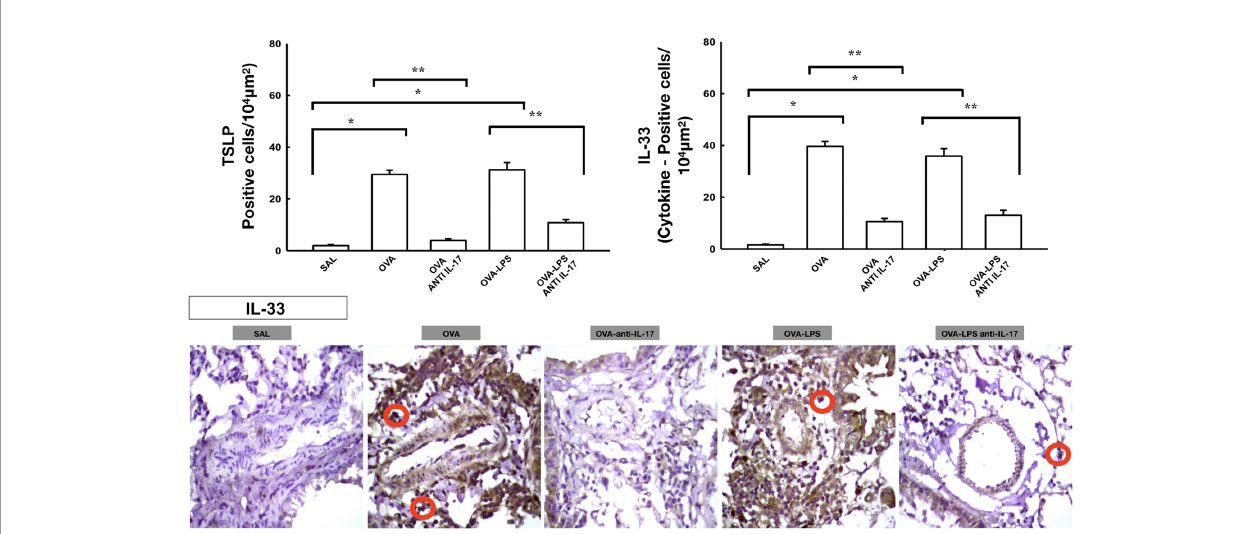
FIGURE 8 | Effects of anti-IL 17 treatment on TSLP and vascular IL-33. The values represent the mean ± SE of TSLP and IL-33 for all experimental groups. The differences were considered signi fi cant when p<0.05. *p<0.05 vs. SAL group; **p<0.05 vs. OVA and OVA – LPS groups. Photomicrograph pulmonary vessels measuring IL-33. The animals exposed to only ovalbumin and ovalbumin plus LPS (OVA and OVA – LPS groups) presented prominent increases in the numbers of positive cells, compared with the control animals (SAL group). Anti-IL-17 treatment in the OVA anti-IL-17 and OVA – LPS anti-IL-17 groups attenuated all increases in these markers. The IL-33 positive cells are identi fi ed by the red